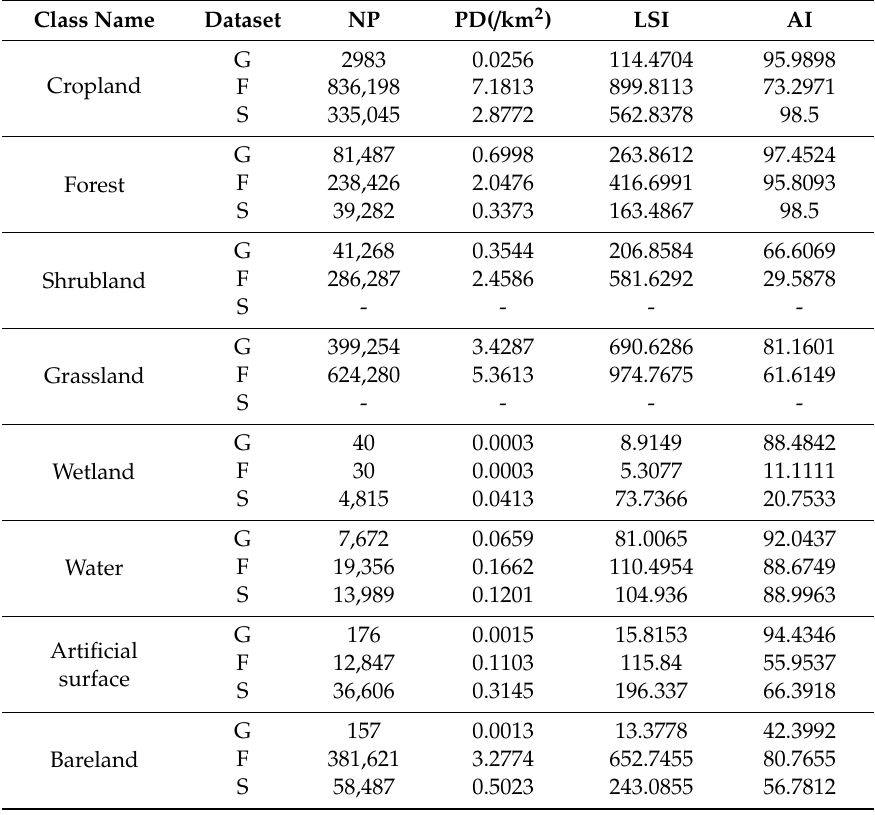
Table 8. The landscape pattern characteristics of various types of land cover